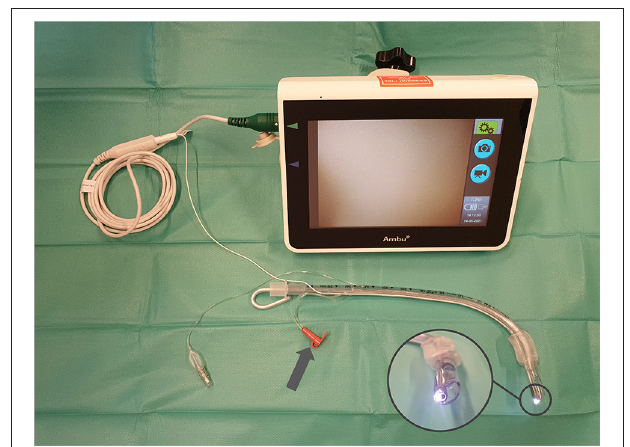
FIGURE 1 | Depiction of the setup of VivaSight-SL tubes. Prepared “optimal” stylet angulation achieved by superposition of 60 intubations in a pretrial manikin training (prepared for difficult airways) by 15 operators. VivaSight-SL tube connected to aView monitor; arrow indicates camera rinsing port; inset depicts camera of